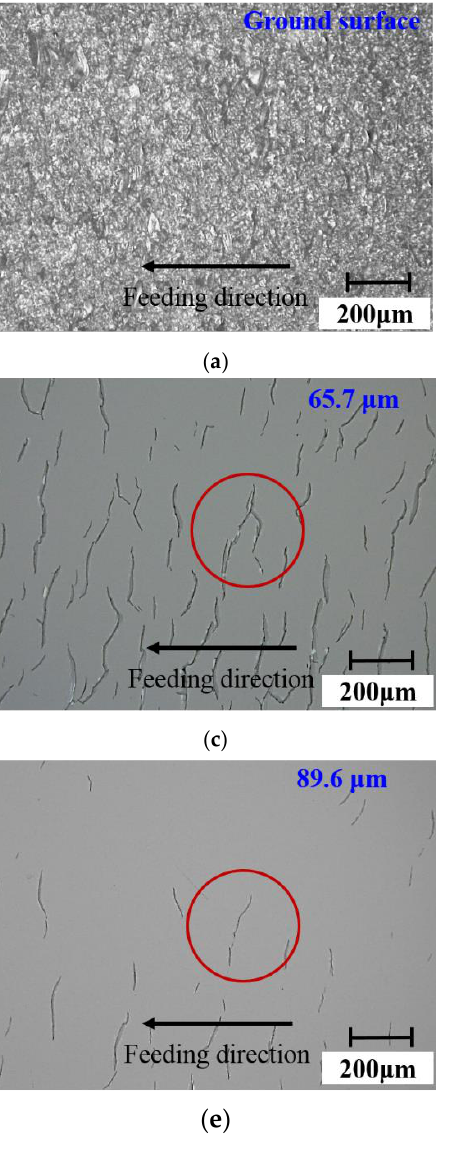
Figure 8. Distribution characteristics of cracks at different subsurface depths under the action of the dressed wheel: subsurface depth ( a ) 0 µ m, ( b ) 42.5 µ m, ( c ) 65.7 µ m, ( d ) 82.9 µ m, ( e ) 89.6 µ m, and ( f ) 96.7 µ m. The red circles in the figure show the variations in a bifurcation crack with subsurface